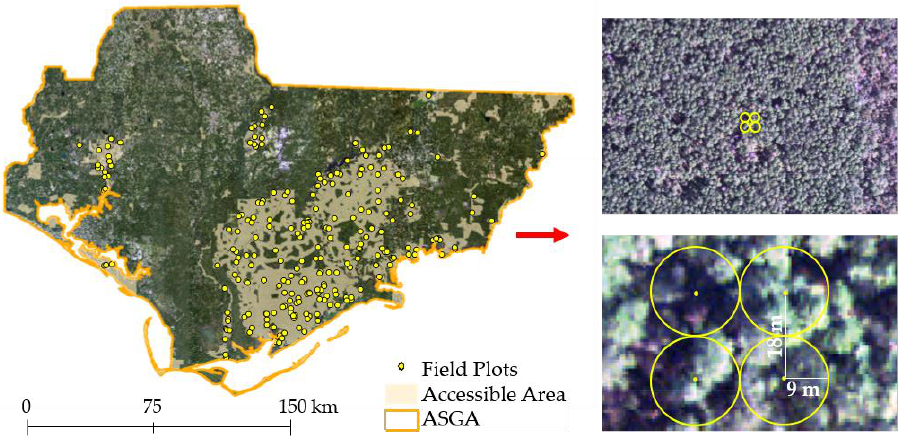
Figure 2. Spatial allocation ( left ) and layout ( right ) of field plots overlaid on aerial imagery. Target population (tan colored region) accounted for approximately 23% of the total area within the ASGA.